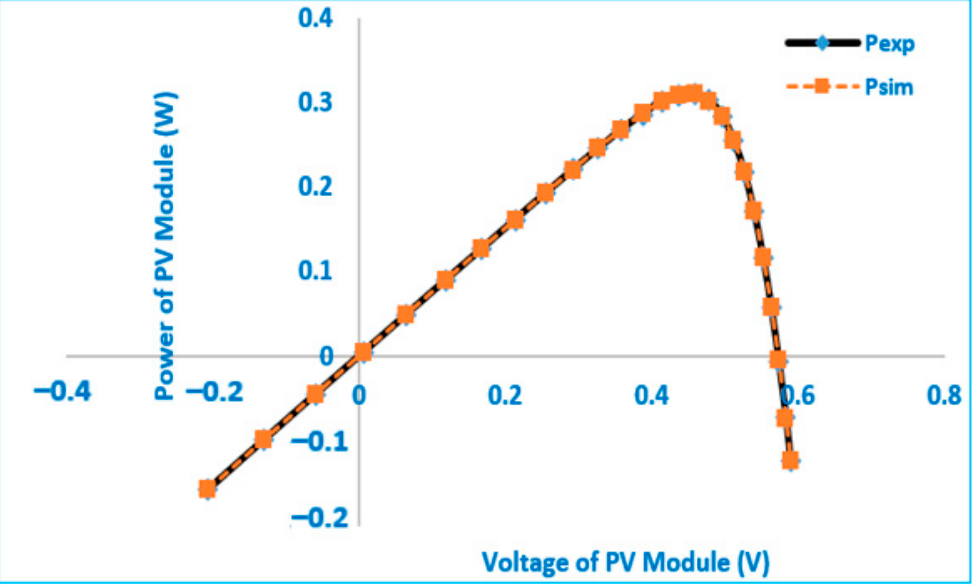
Figure 15. P–V characteristics of the proposed HPO technique for the triple-diode of RTC France PV cell.